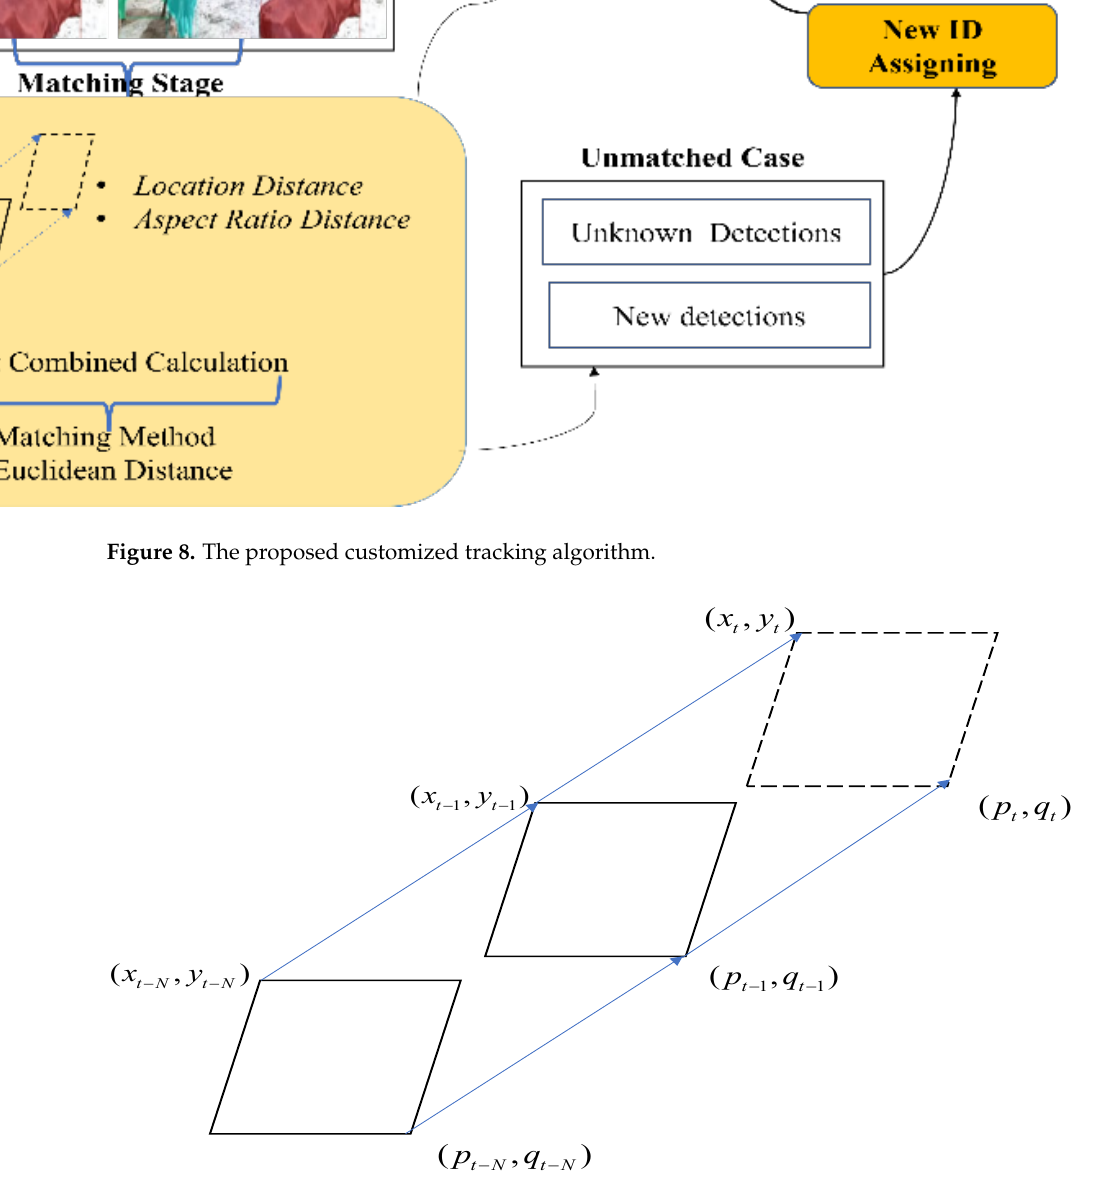
Figure 9. The explanation of the customized tracking algorithm, where (x, p) and (y, q) are the left upper point and the right upper point, respectively. The index t-N represents the N frame previous detection; t-1 represents the previous detection; and t means the current frame location.